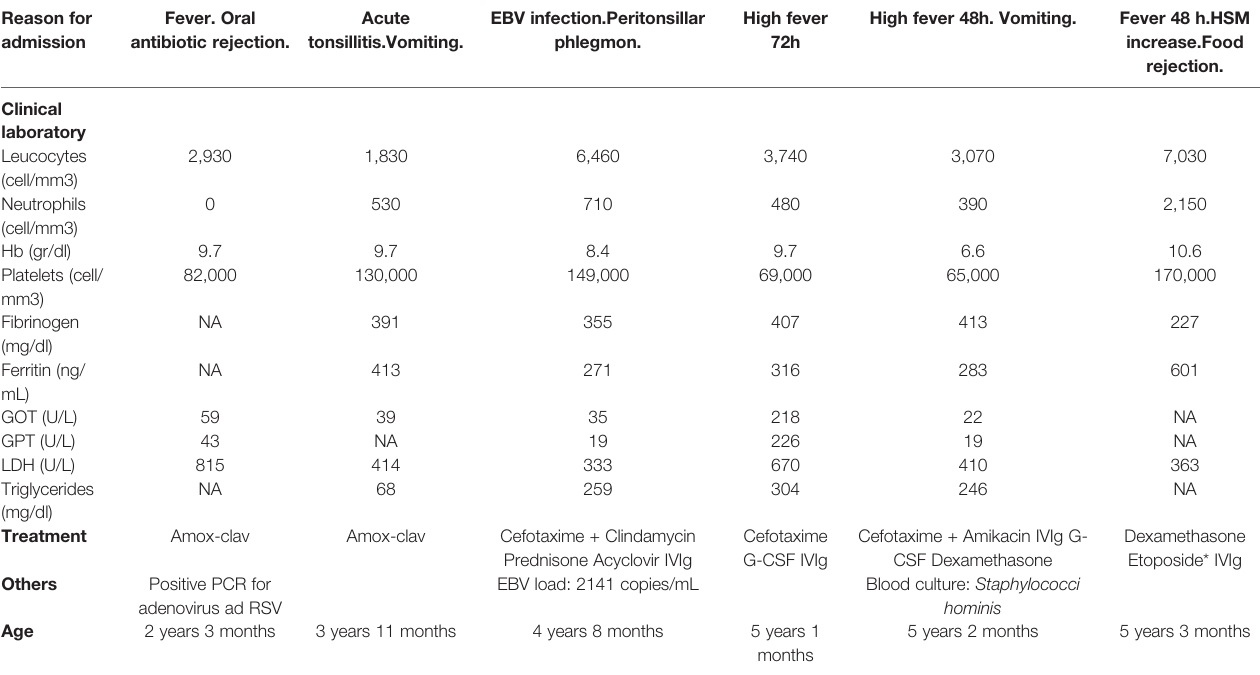
TABLE 1 | Patient ’ s clinical and treatment progression from the fi rst admission to date. Reason for Fever. Oral admission antibiotic